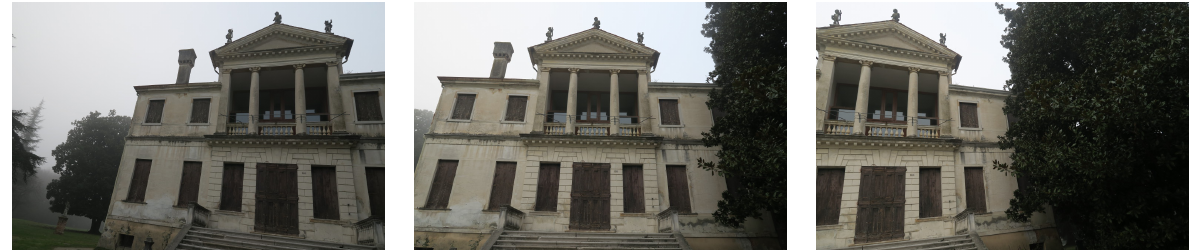
Figure 1. Panoramic–like image acquisition of the fac¸ade of Villa XXV Aprile, Mirano, Italy.